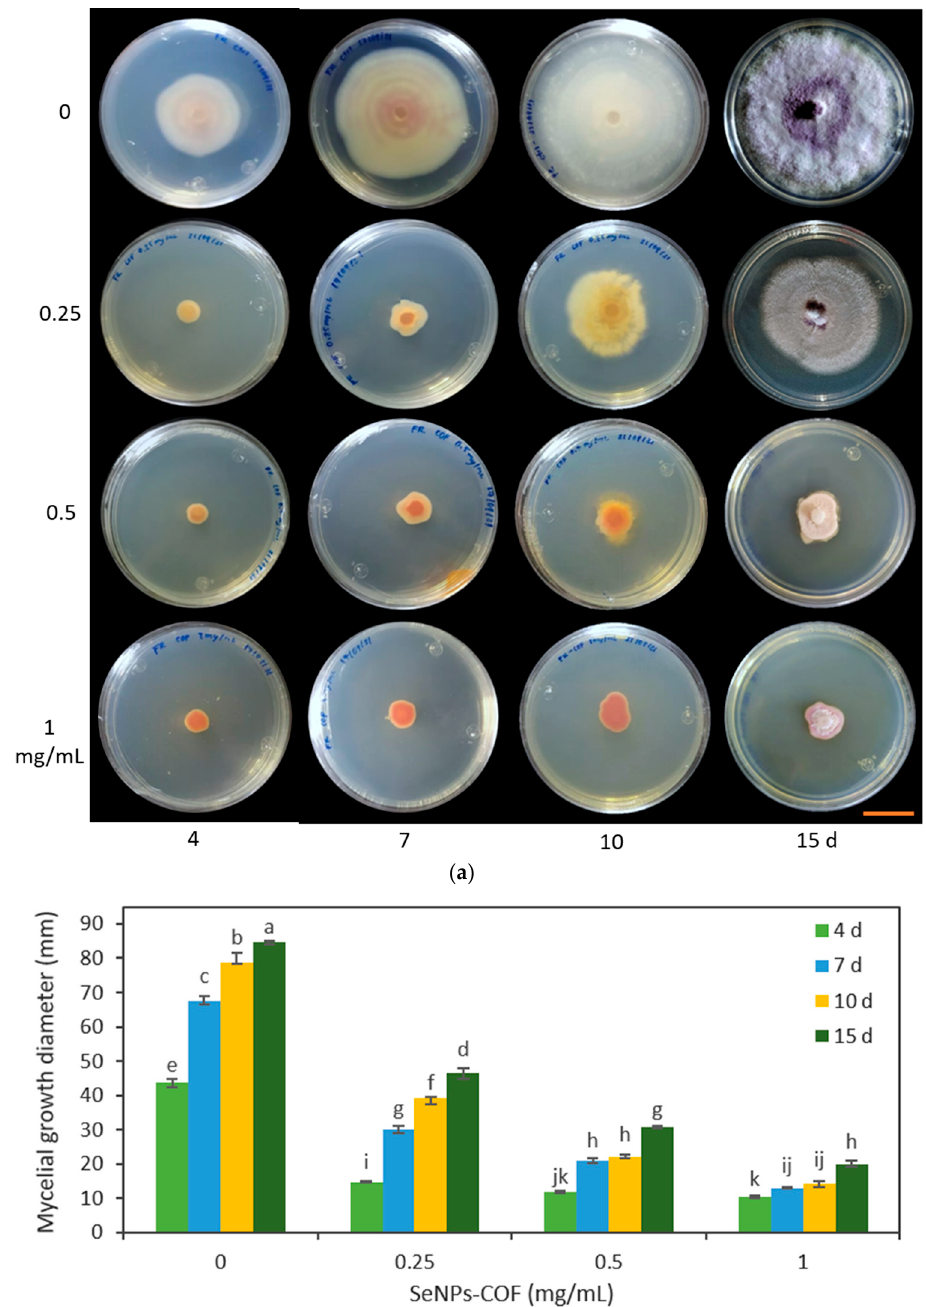
Figure 9. Effect of different concentrations of SeNPs synthesized with C. officinalis (COF) extracts against F. oxysporum . ( a ) Representative photograph of the antifungal activity test under different concentrations over time. SeNPs were applied at 0.25, 0.5, and 1 mg/mL. The scale bar is 2.5 cm. ( b ) Mean comparison of the effect of the SeNPs synthesized with extracts of C. officinalis against F. oxysporum at different concentrations. Mean values ± ee. Different letters indicate statistically significant differences according to Duncan’s test ( α = 0.05), p < 0.0001.